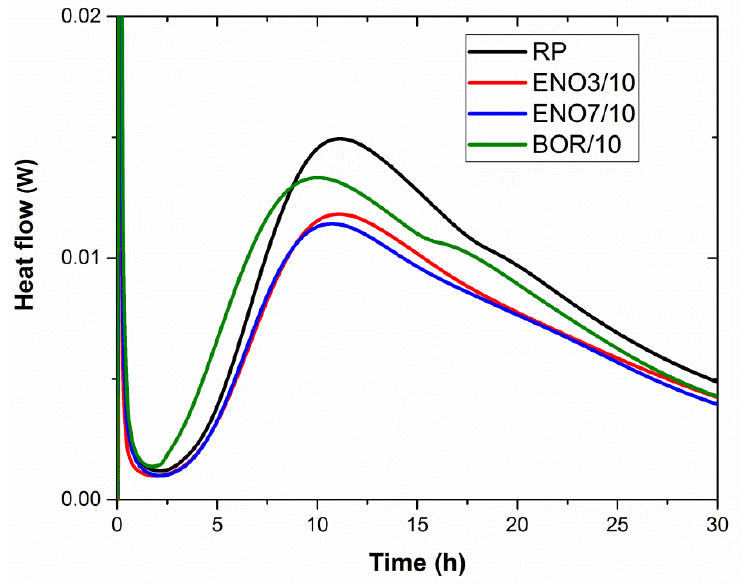
Figure 5. The calorimetric curves of tested pastes were obtained during the first 30 min.